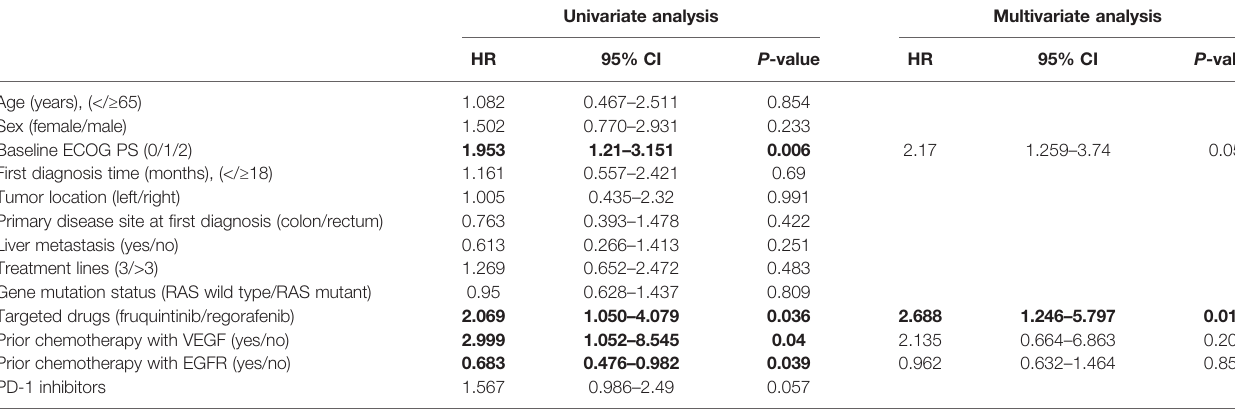
TABLE 4 | Univariate and multivariate analyses of risk factors for progression-free